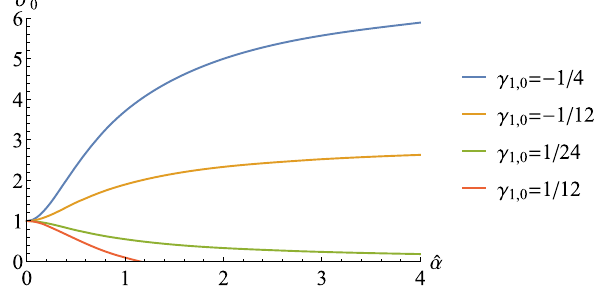
Fig. 15 The DC conductivity as a function of ˆ α for only γ 1 , 0